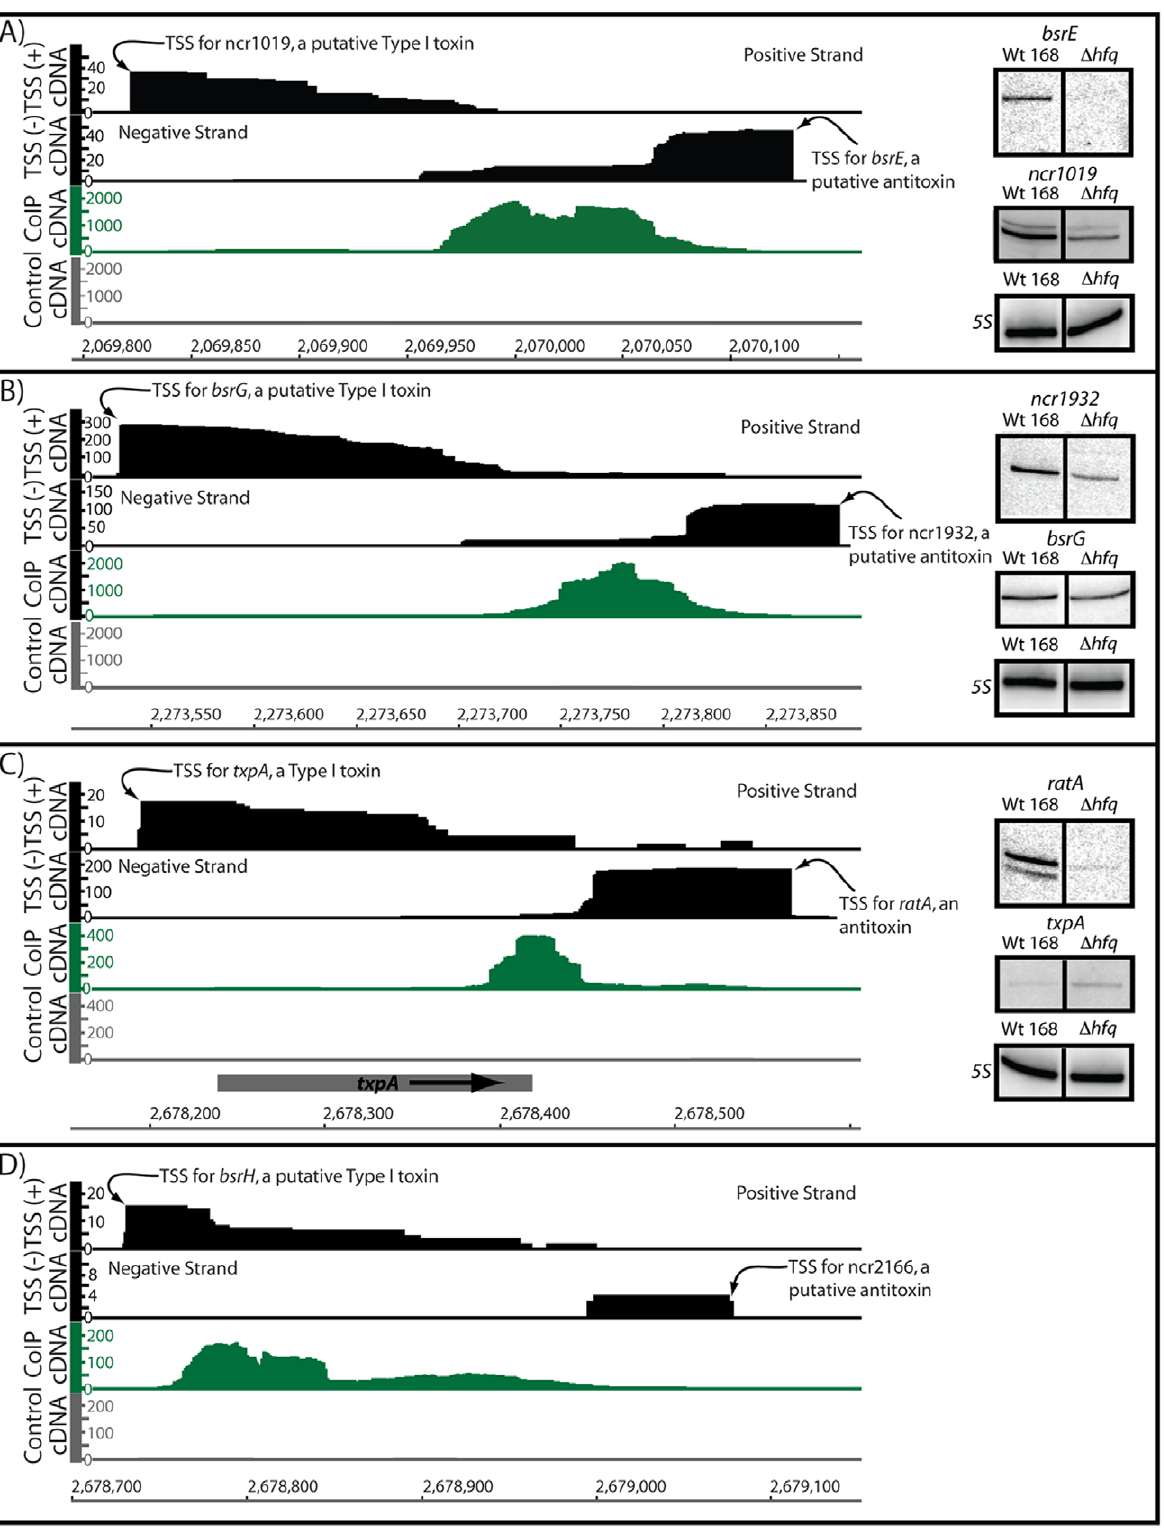
Figure 5. Hfq associates with type I antitoxin transcripts. (A–D) A previous study of B. subtilis transcription start sites (TSS) [33] revealed the presence of at least four putative type I toxin:antitoxin systems. The TSS data from this study are shown in black in this figure to indicate the orientation of these RNA transcripts, relative to regions of Hfq enrichment. In this study, Hfq appeared to preferentially associate with the antisense transcripts. In particular, the sequences that appeared to coIP with Hfq corresponded most often to the portions of the antitoxin transcripts that are predicted to base pair with the toxin-encoding mRNAs. Located to the right are northern blots for each corresponding toxin:antitoxin pair for wild-